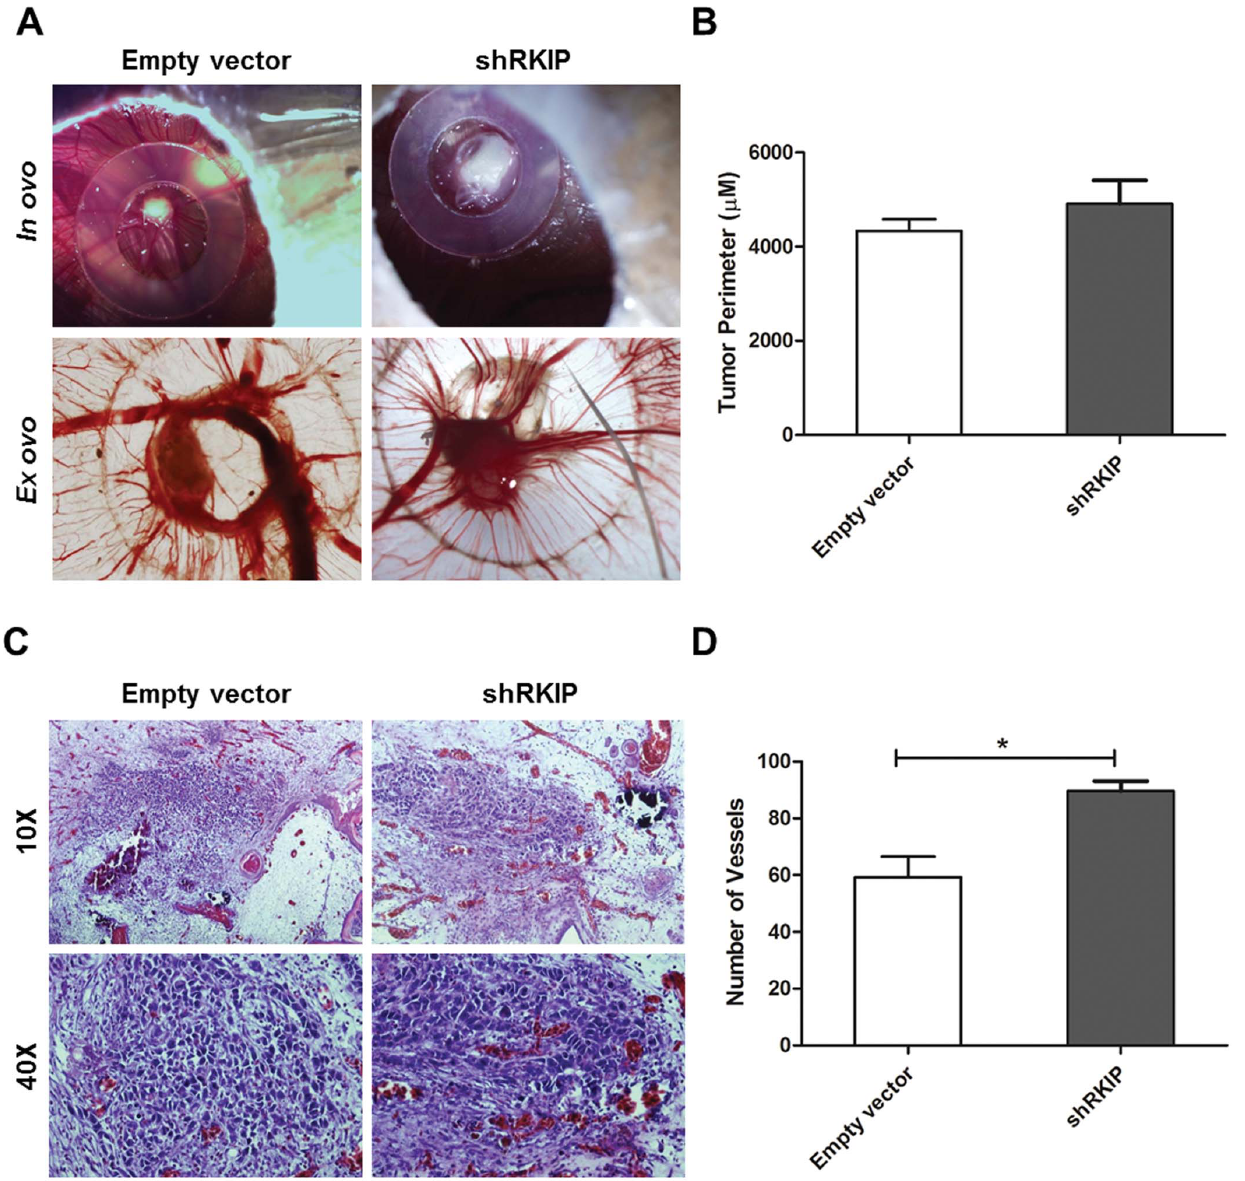
Figure 4. Invivo role of RKIP in HeLa cells growth and angiogenesis. A) Representative pictures (16 6 magnification) of CAM assay after 7 days of tumor growth in ovo and ex ovo . B) Tumor growth was measured in vivo by CAM assay as described in materials and methods section. It was observed a higher perimeter ( m M) of the tumors ( in ovo ) formed by shRKIP cells, however the difference between the control cells was not significant. C) Hematoxylin-eosin staining of the paraffin embedded tumors showing the higher vascularization induced by RKIP inhibition. Representative pictures with 10 6 and 20 6 magnification are represented in the left panel. D) Counting of the blood vessels ex ovo , it was observed a statistically significant increase on the number of vessels recruited in the tumors formed by shRKIP cells when compared to the control. In total it was analyzed 20 eggs (10 were injected with empty vector and 10 with shRKIP cells). The data is represented as the mean 6 SD and differences with a p , 0.05 on the Student’s t test were considered statistically significant